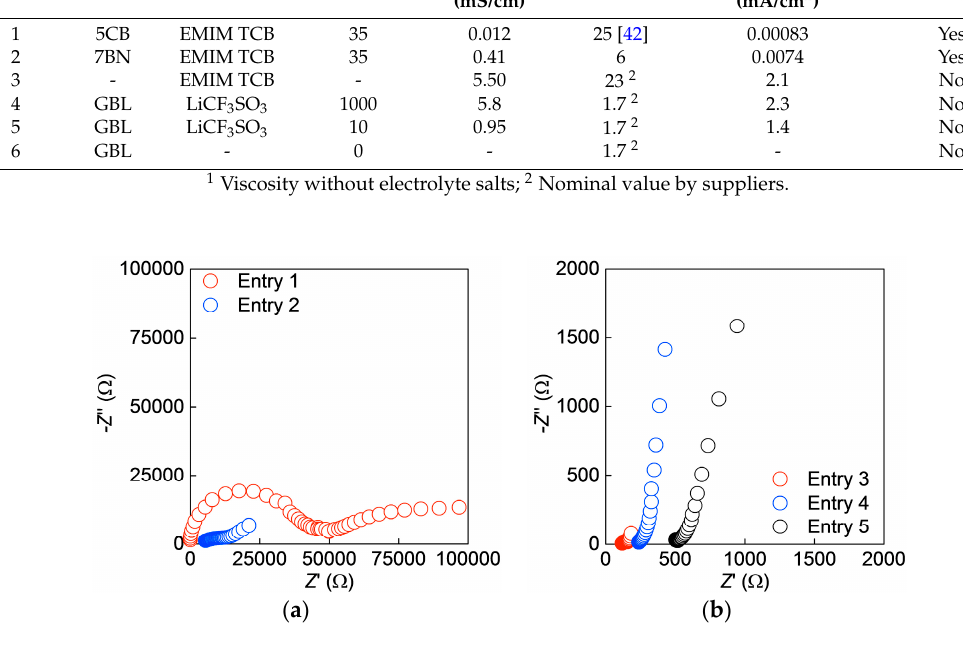
Figure 8. Nyquist plots for thin layer electrodes of 1 measured in a series of electrolytes shown in Table 2. Electrodes were measured at a bias of E = E 1/2 vs. Ag/AgCl. AC amplitude was 20 mV (Entry 1–2) or 5 mV (Entry 3–5). Frequency range: ca. 10 4 –10 0 Hz.